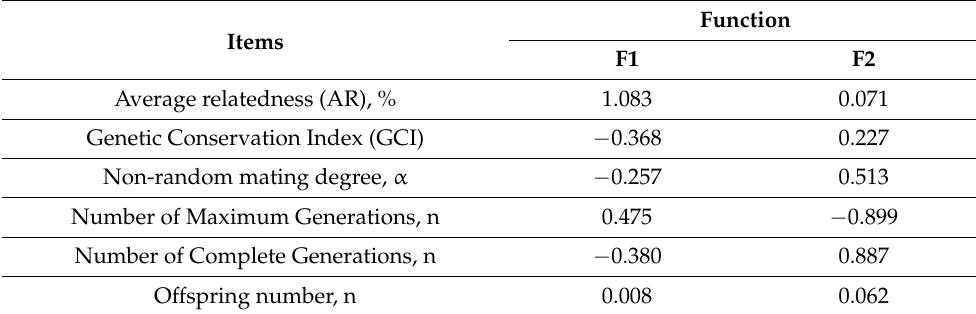
Table 11. Standardized coefficients for zoometric